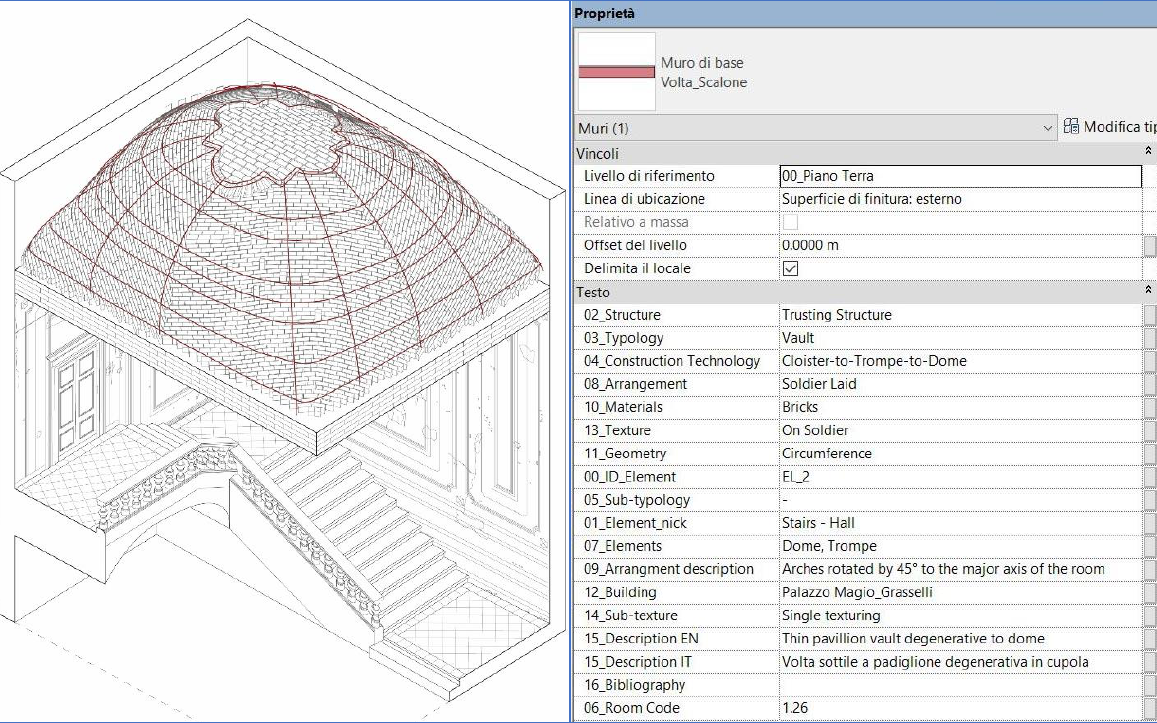
Figure 12. HBIM 3D model and bricks arrangement